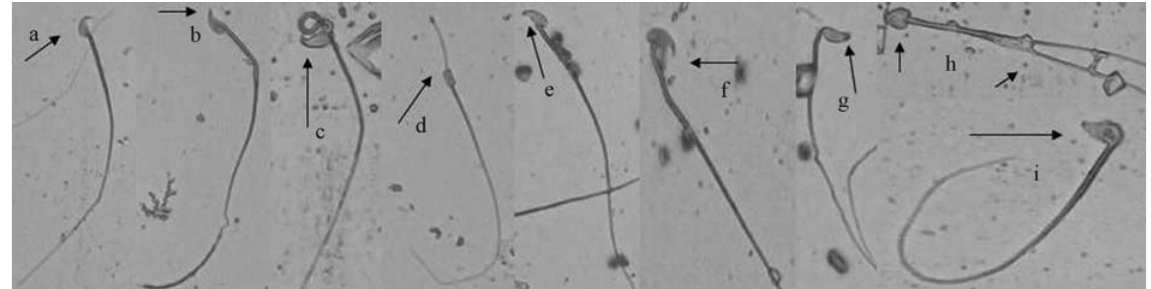
Figure 5 - Abnormal sperm cells induced in mice exposed to different concentrations of the pharmaceutical effluent (a) normal sperm cell, (b) wrong-angled hook, (c) folded sperm, (d) pin head, (e) very short hook, (f) wrong tail attachment, (g) No hook, (h) double-tailed sperm with amorphous head, (i) amorphous head. Magnification